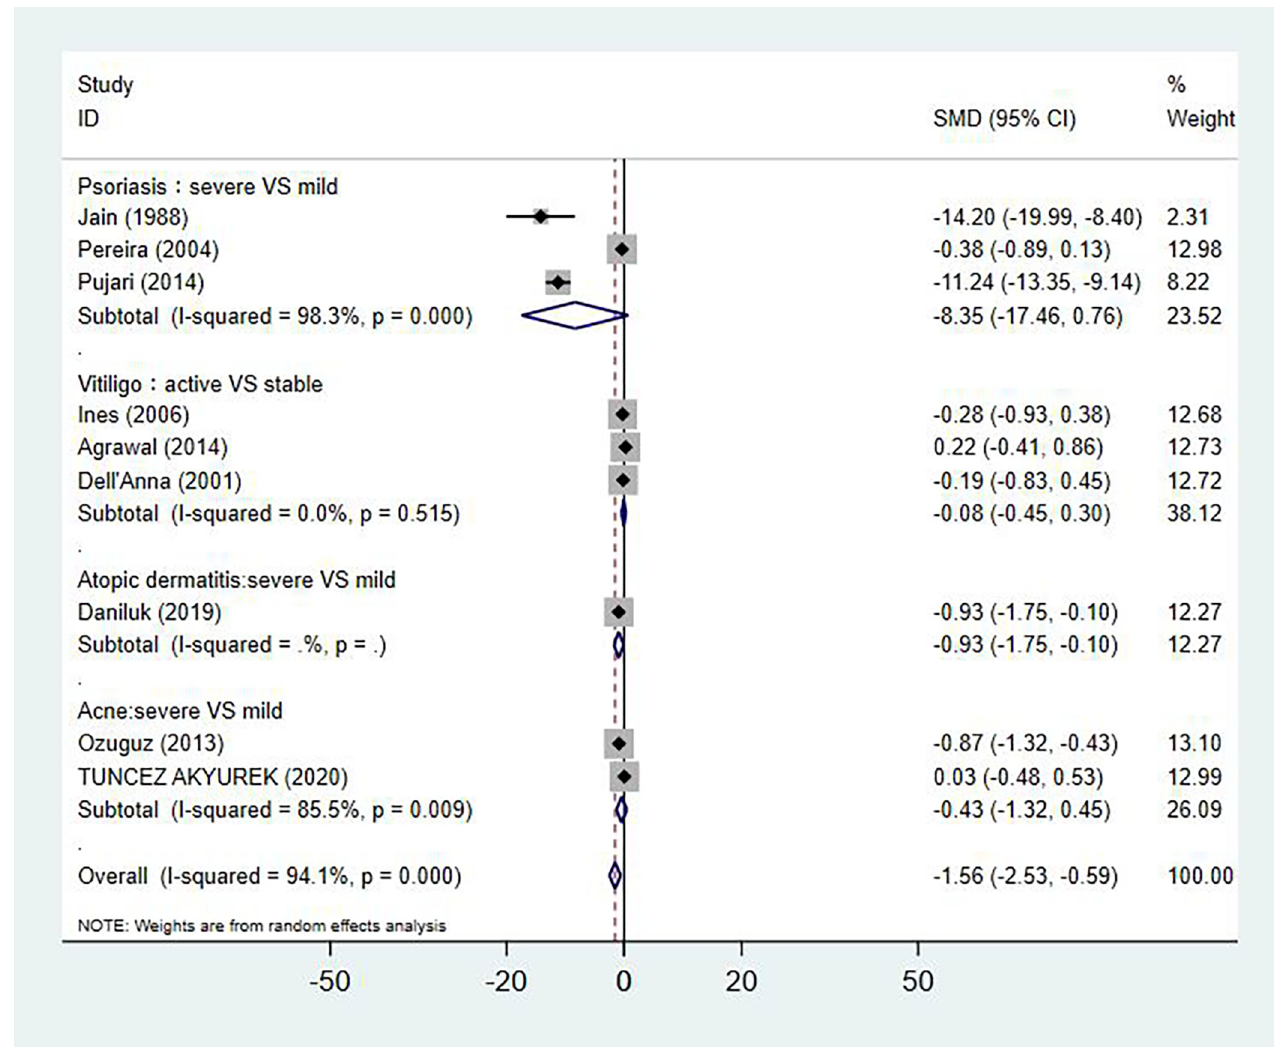
Fig 6. Forest plot in the meta-analysis of vitamin E levels and skin disease severity.